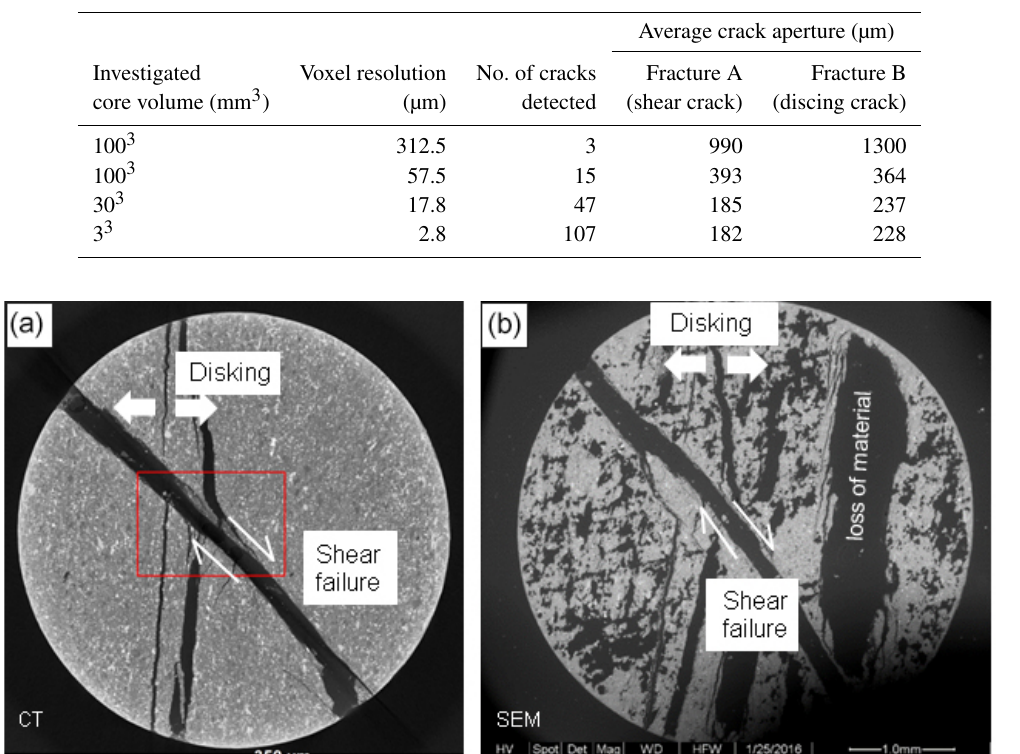
Figure 11. Sample overview: (a) X-ray CT image of a single layer; (b) SEM image of the polished